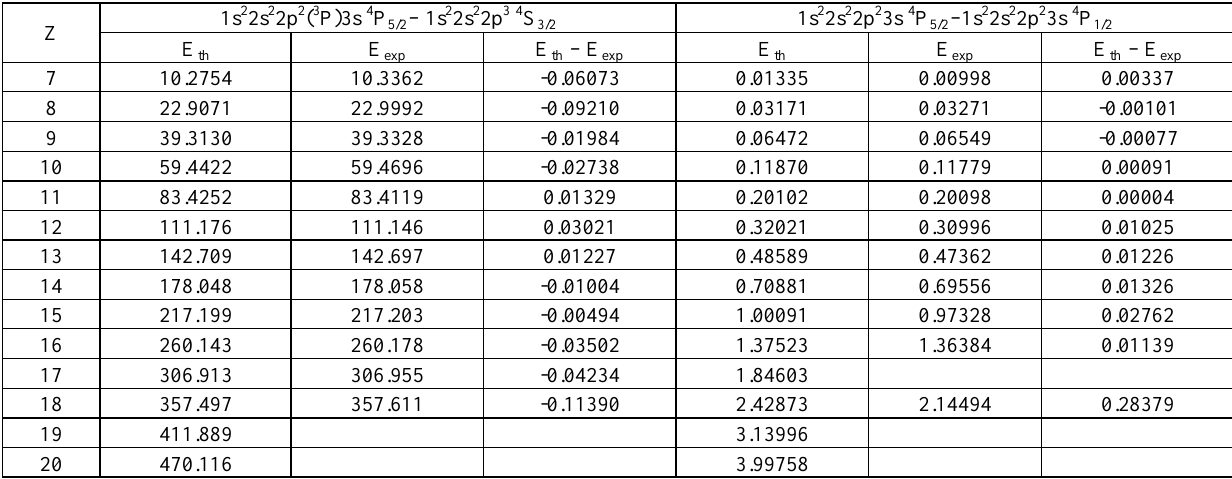
Comparison with experiment of the calculated energies of 1s 2 2s 2 2p 2 ( 3 P)3p 4 D 7/2 , 1s 2 2s 2 2p 2 ( 3 P)3p 4 P